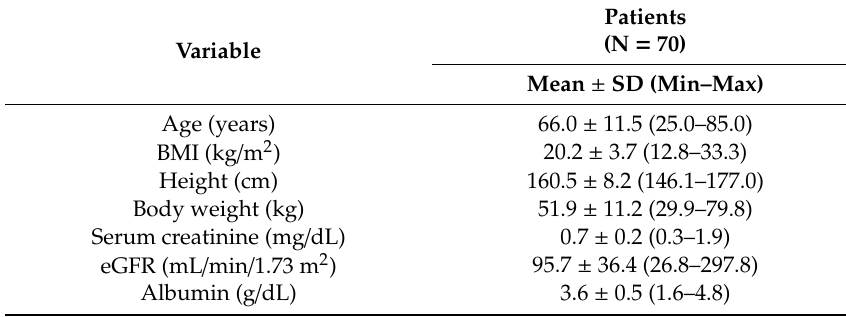
Table 1. Demographic characteristics of